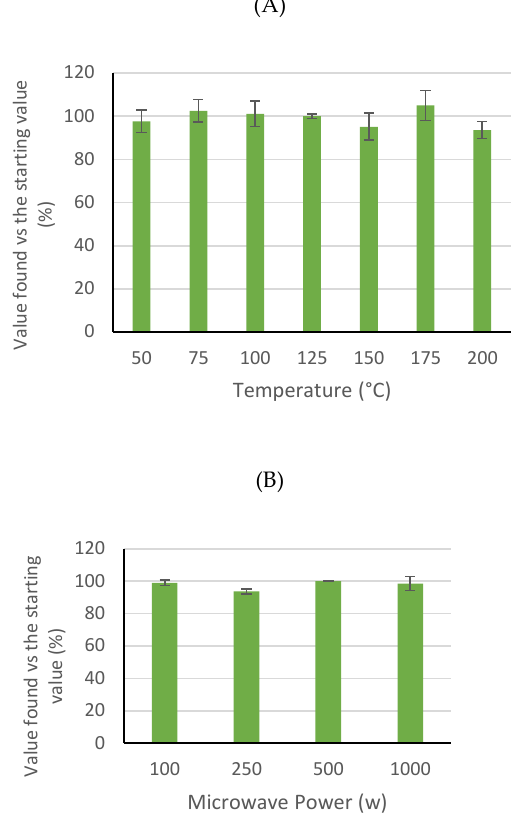
Figure 2. Stability of ricinine solutions (mean ± RSD; n = 3) under di ff erent microwave assisted extraction conditions: ( A ) Temperature and ( B ) Microwave Power. Values vs. the maximum level found in the solutions